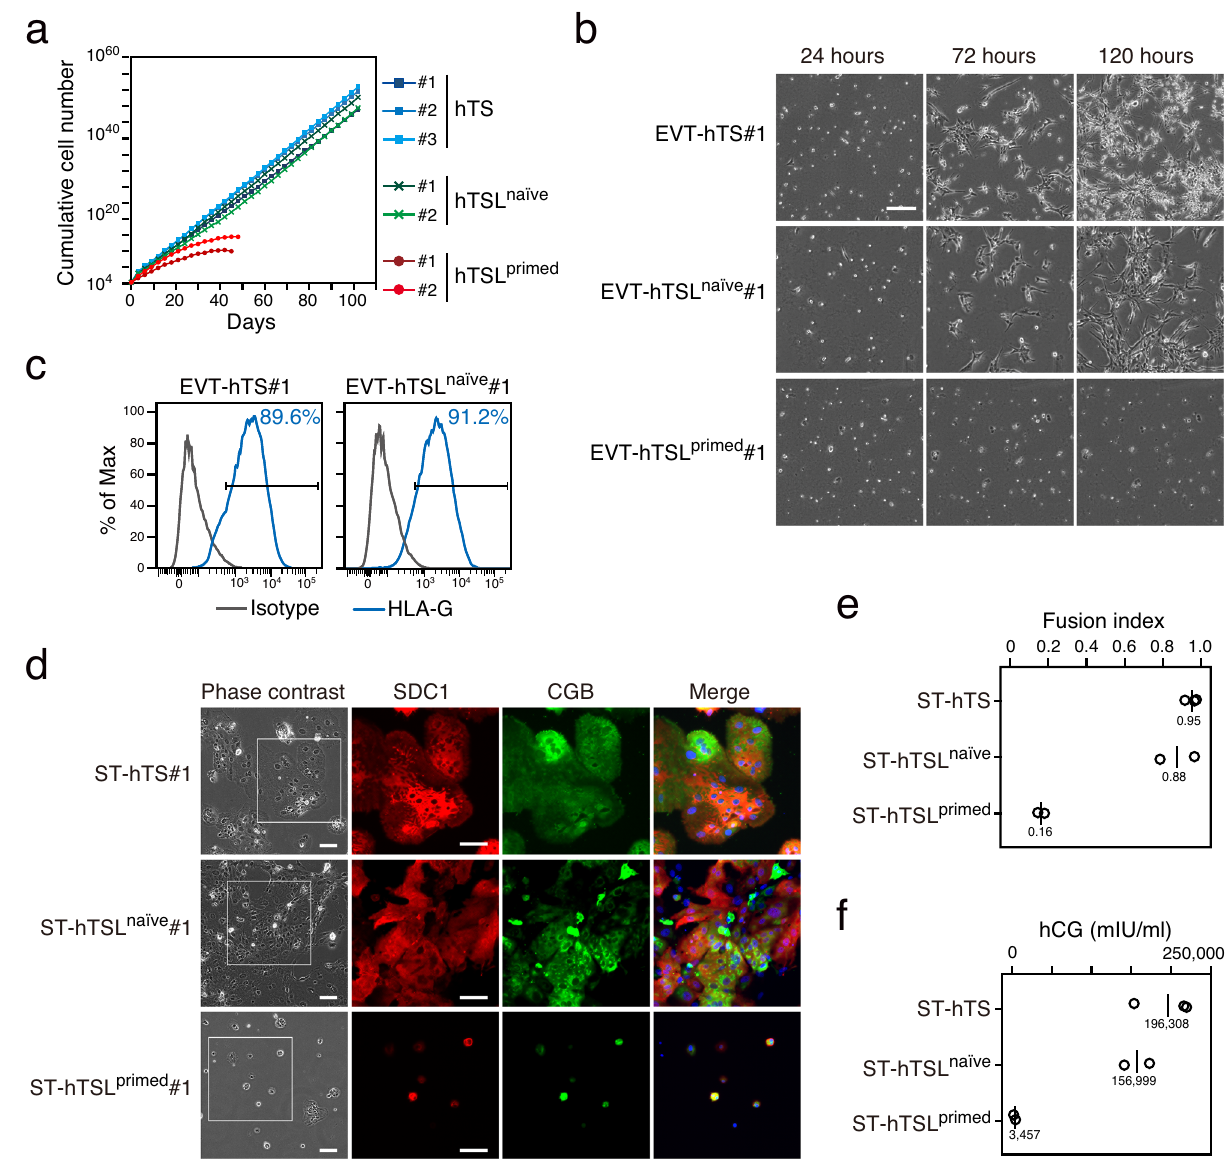
Fig. 2 Proliferation and differentiation potentials of hTSL cells. a Growth curve of hTS and hTSL cells. Although hTS and hTSL naïve cells could be stably maintained for more than 100 days, hTSL primed cells stopped proliferation within 50 days. b Time-lapse analysis of EVT-like cells differentiating from hTS and hTSL cells. The phase-contrast images are taken from time-lapse Supplementary Movie 1 – 3. The scale bar indicates 300 μ m. Similar results were obtained with two independent cell lines. c Flow cytometry analysis of HLA-G expression on EVT-like cells derived from hTS and hTSL naïve cells. Representative data obtained from two independent cell lines are shown. d Phase contrast and immuno fl uorescence images of ST-like cells derived from hTS and hTSL cells. Cells were stained for SDC1 and CGB. Nuclei were stained with Hoechst 33258. The scale bar indicates 100 μ m. Similar results were obtained with two independent cell lines. e Fusion ef fi ciency of ST-hTS and -hTSL cells. The fusion index is de fi ned as (N-S)/T, where N is the number of nuclei in the syncytia, S is the number of syncytia, and T is the total number of nuclei counted. Three ST-hTS, two ST-hTSL naïve , and two ST-hTSL primed cell lines were analyzed. Black bars and numbers indicate the mean fusion indexes. f Levels of hCG secreted by ST-hTS and -hTSL cells. Three ST-hTS, two ST- hTSL naïve , and two ST-hTSL primed cell lines were analyzed. Black bars and numbers indicate the mean amount of of hTSL primed cells, we compared the transcriptome pro fi le of hTSL primed cells with those of hTS and hTSL naïve cells. This